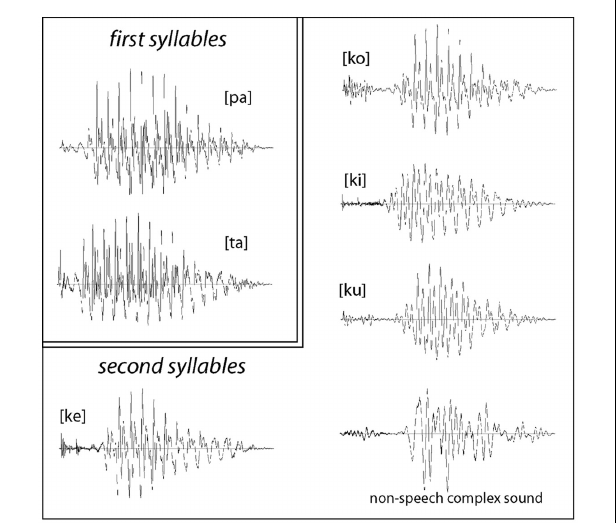
FIGURE 1 |Waveforms of acoustic stimuli used in the experiments: all stimuli were composed of the same first syllables [pa] and [ta], which were recombined (after a 275 silent closure) with the second syllables [ku], [ko], [ke] [ki], and a matched non-speech sound. The stimuli were maximally matched for their acoustic properties, whilst their lexical status as familiar or novel items was systematically